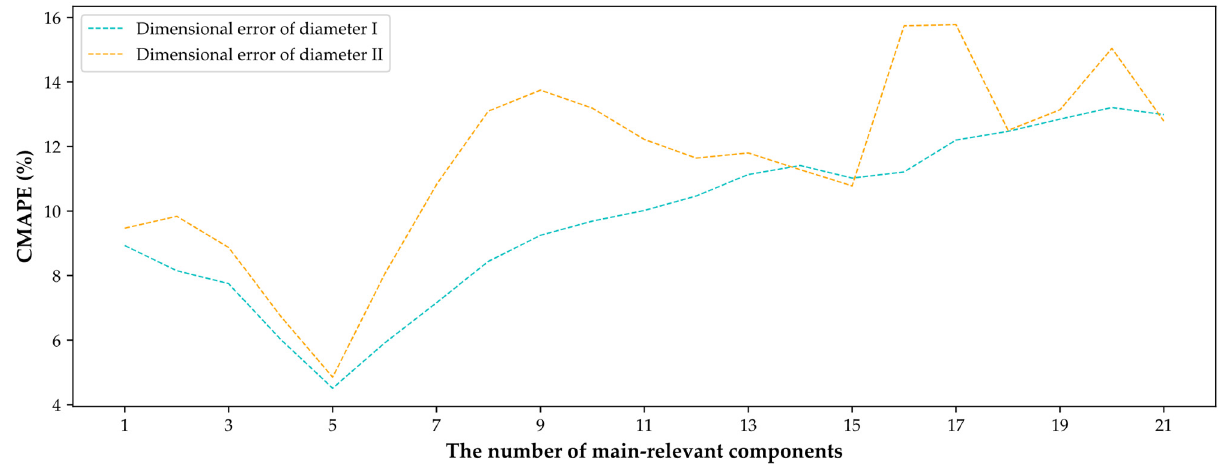
Figure 8. The performance of the main relevant component number on the testing